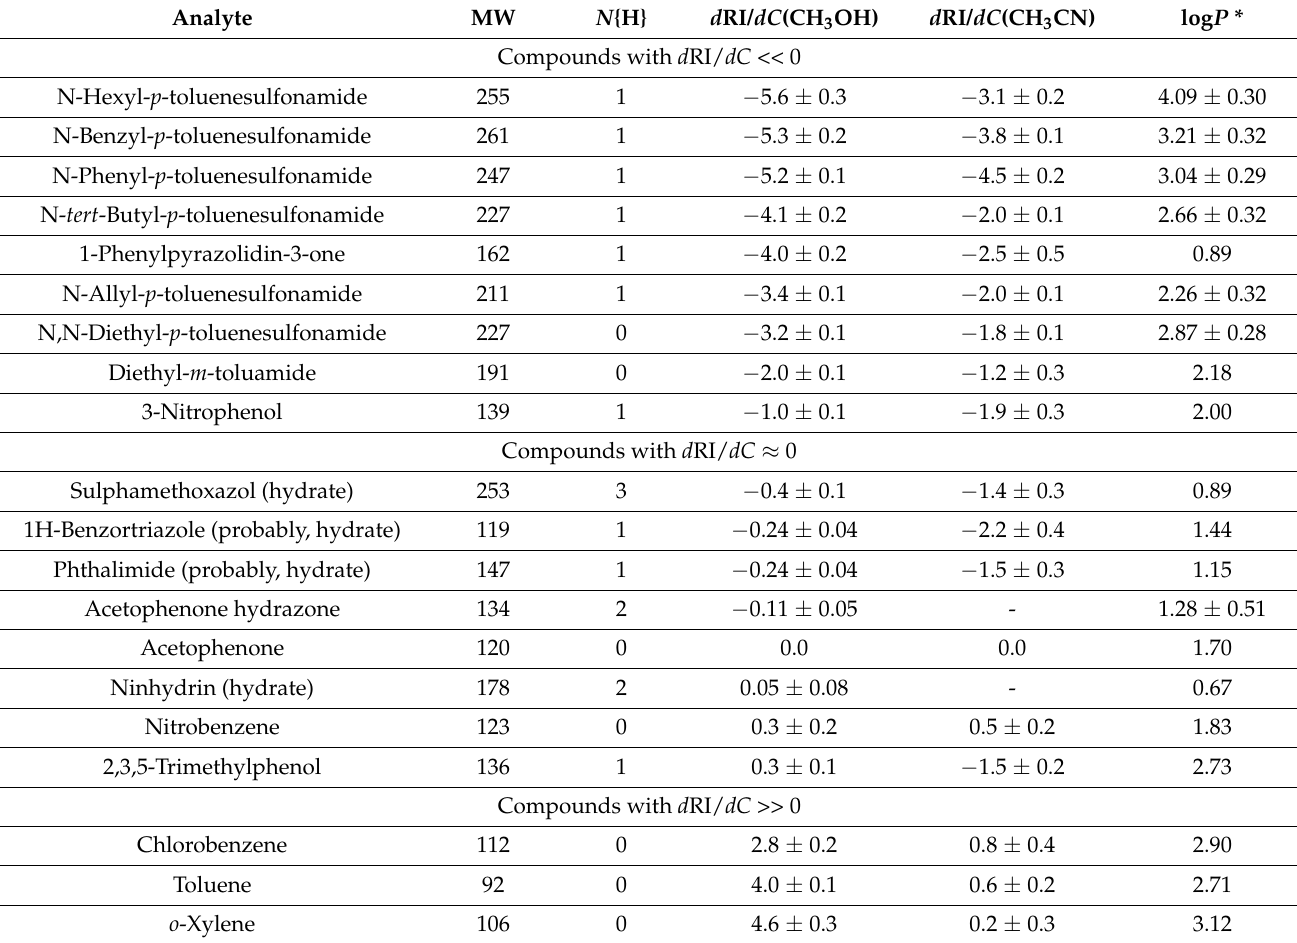
Table 6. Coefficients of the dependencies of the retention indices vs. the concentrations of the organic components in the eluents. All analytes are listed in the order of increasing d RI/ dC (CH 3 OH) values. Analyte MW N {H} Compounds with d RI/ dC << 0